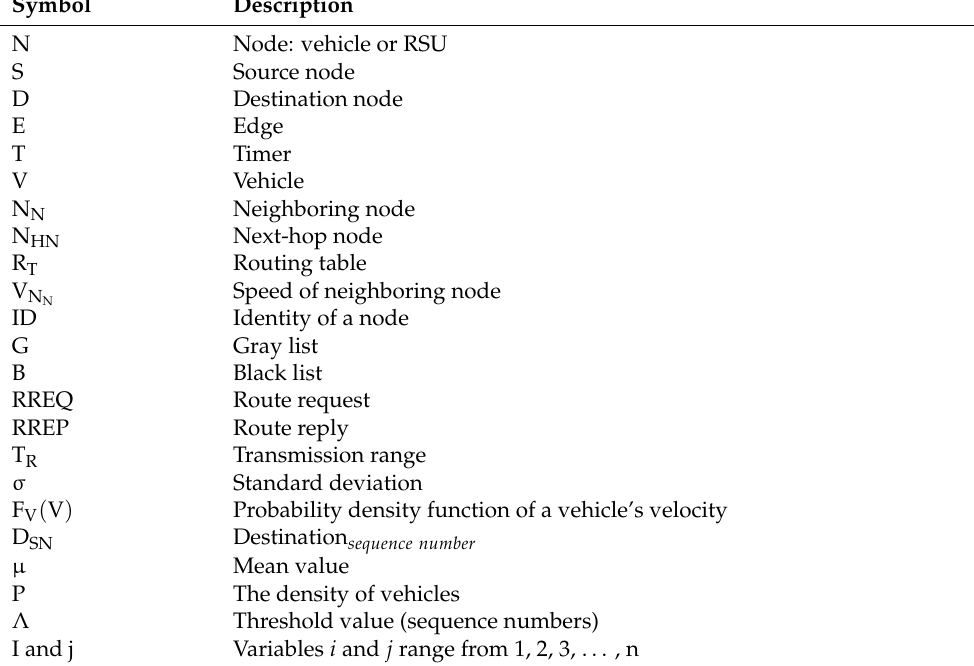
Table 2. Notations and their